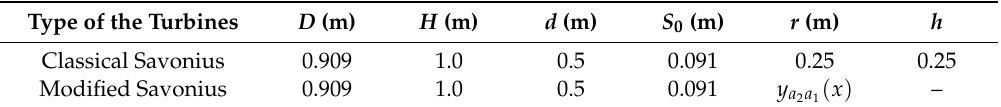
Table 1. Main geometrical parameters of turbine rotors.